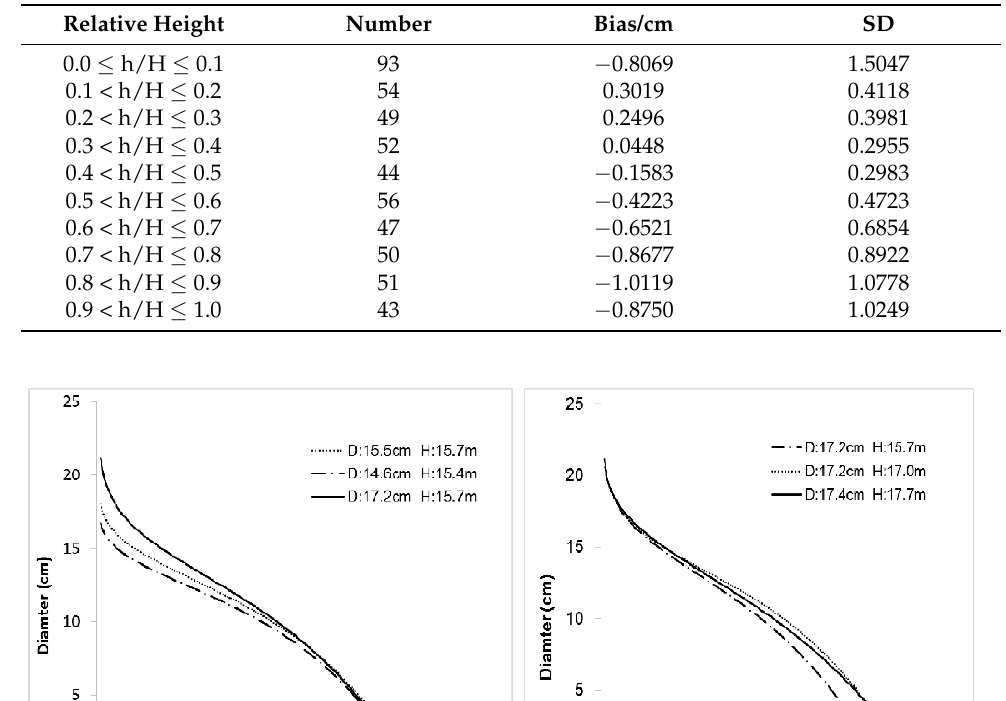
Table 7. Examined statistics of Kozak [1] mixed model with tree-level effects.